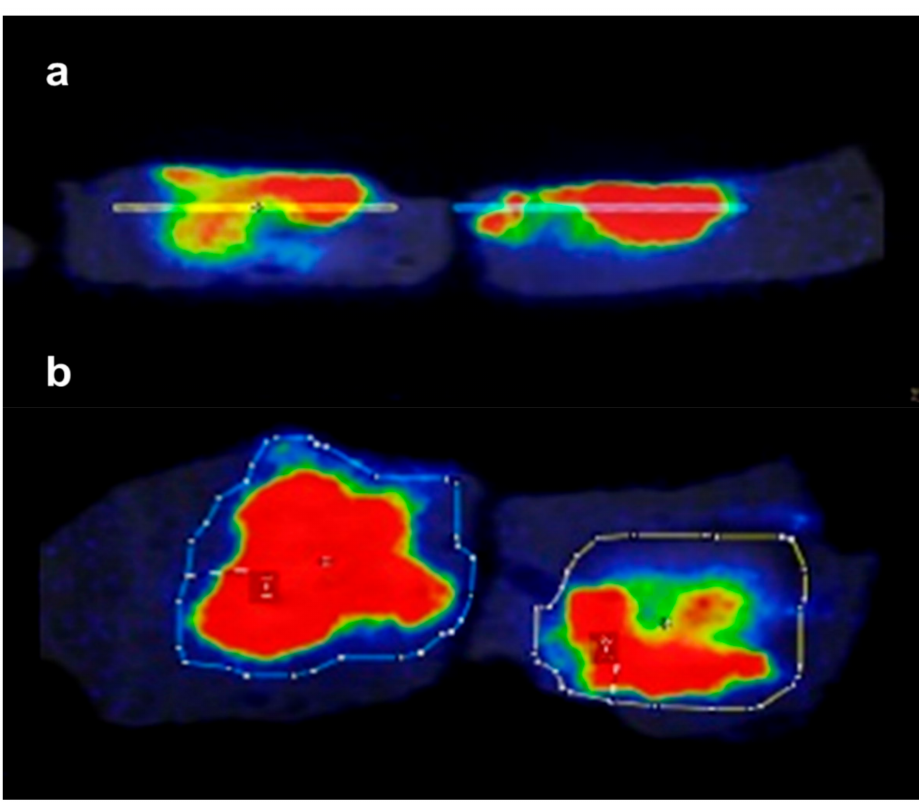
Figure 5. 18 F-fluorodeoxyglucose ( 18 F-FDG)-positron emission tomography/magnetic resonance imaging examination imaging in the extracted liver. ( a ) Sagittal sections of the extracted liver. ( b ) The focal 18 F-FDG uptake on transverse cut sections was calculated by drawing the regions of